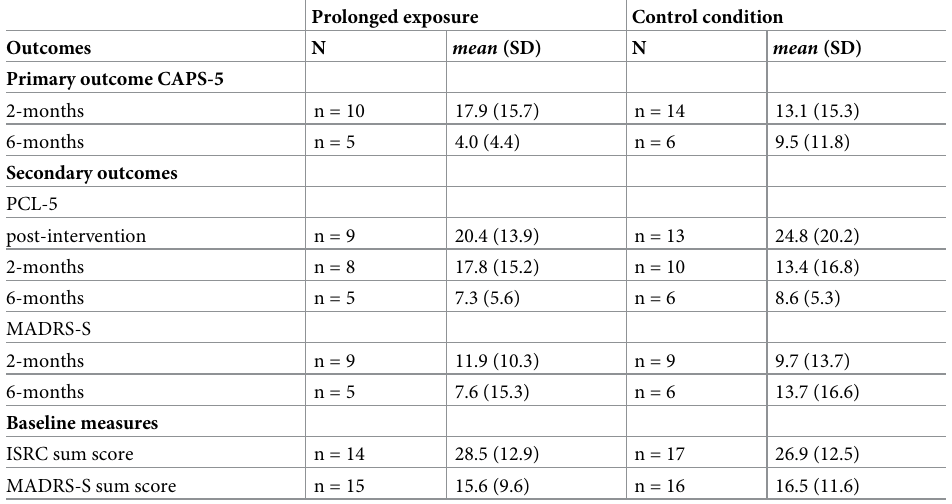
Table 2. Treatment outcomes for included participants by intervention condition.